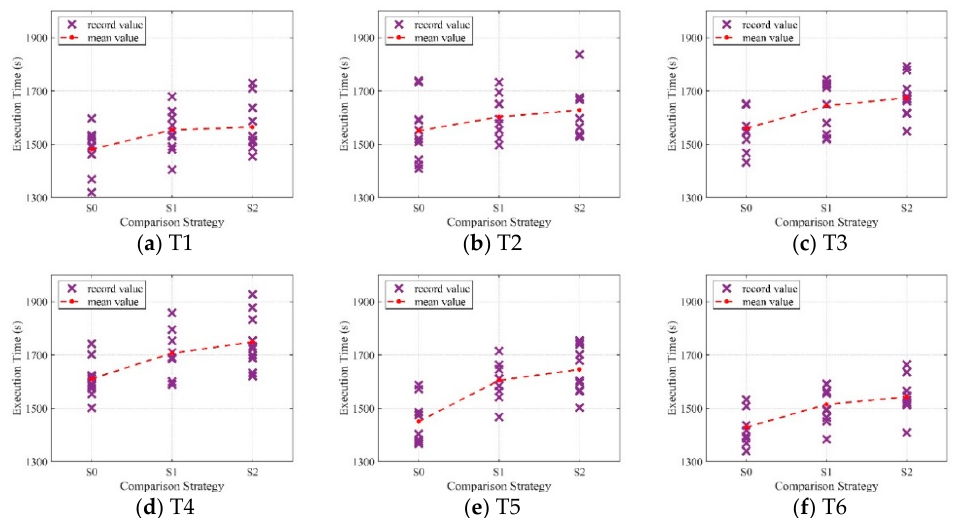
Figure 8. Execution time of three comparison strategies for T1 to T6 using the SLIC algorithm with eight executors.